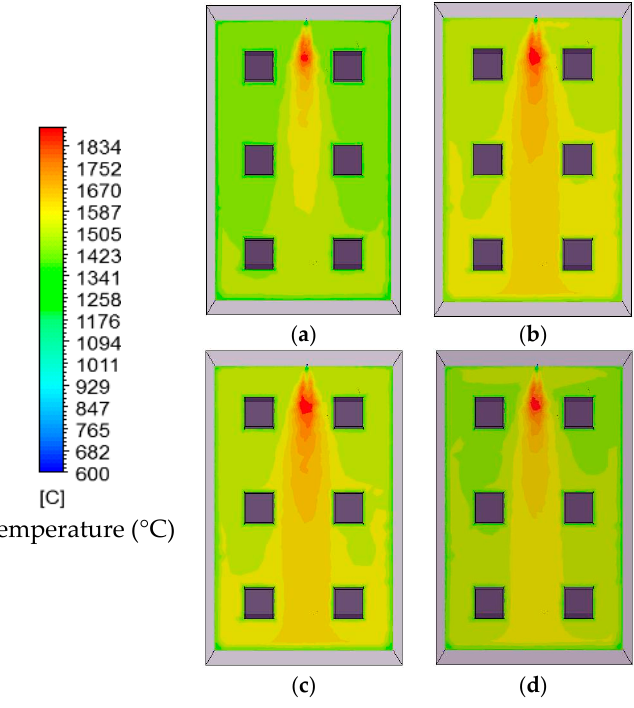
Figure 8. Predicted temperature (°C) profiles on a x - z surface in the middle of the furnace for selected cases: ( a ) Case 1; ( b ) Case 3; ( c ) Case 5; and ( d ) Case 6.